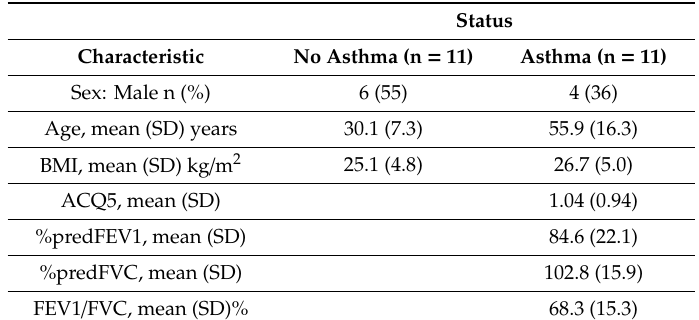
Table 1. Participant information for the study, stratified by health status.